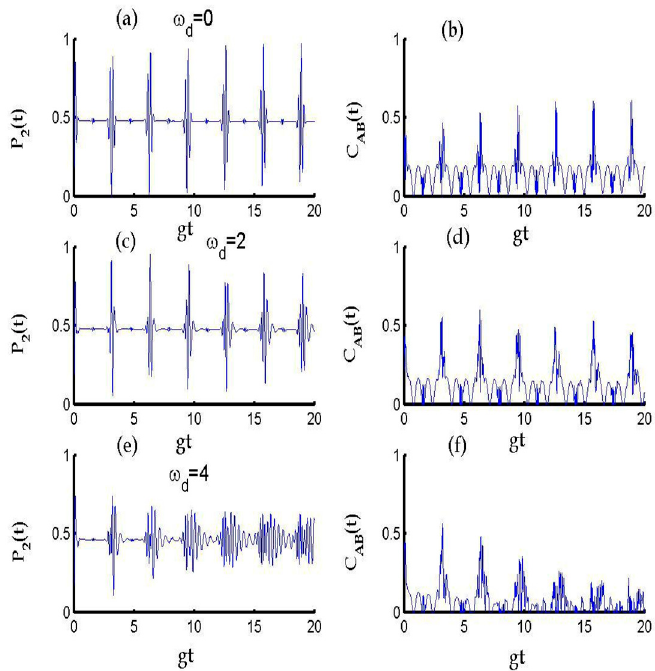
Figure 4. (Color Online) The probability and entanglement are plotted versus the dimensionless time gt for various values of the energy detuning for two-photon transition ( l = 2) in the absence of atomic motion effect G ( t ) = g with | α | 2 = 10. ( a , c , e ) display the variation of the population for a single-excitation with the time; ( b , d , f )present the evolution of the concurrence of the donor-acceptor state during the time evolution. ( a , b ) is for ω d = 0; ( c , d ) is for ω d = 2; and ( e , f ) is for ω d = 4.